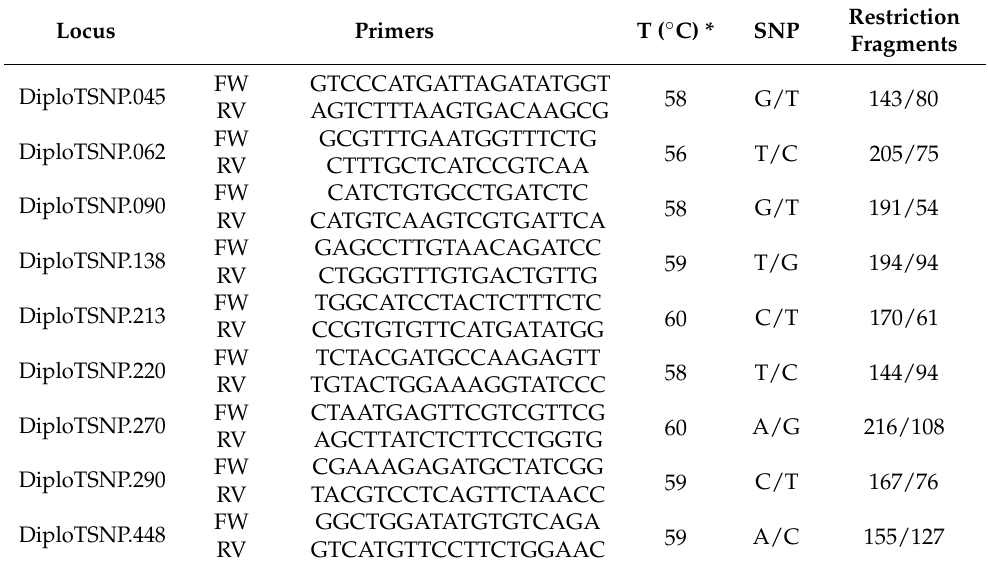
Table 2. SNP-CAPS Markers Used for Accession